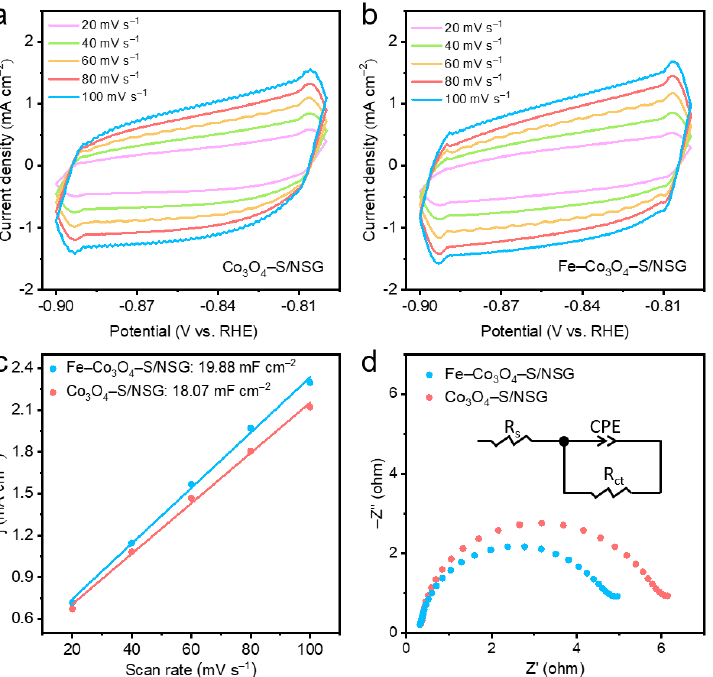
Figure 5. The CV curves at various scan rates of 20, 40, 60, 80, and 100 mV s –1 for ( a ) Co 3 O 4 –S/NSG and ( b ) Fe–Co 3 O 4 –S/NSG. ( c ) The corresponding value of C dl . ( d ) EIS spectra of Co 3 O 4 –S/NSG and Fe–Co 3 O 4 –S/NSG, the illustration shows the corresponding equivalent circuit.